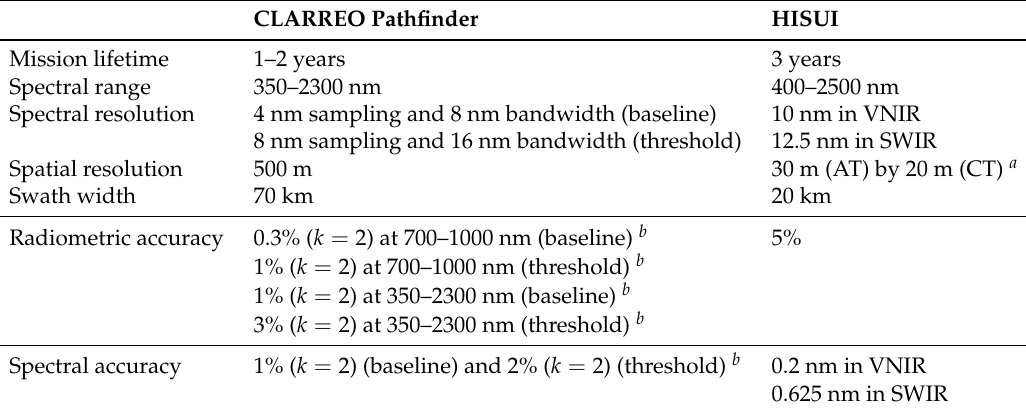
Table 1. Specifications for the CLARREO Pathfinder [5,36] and HISUI